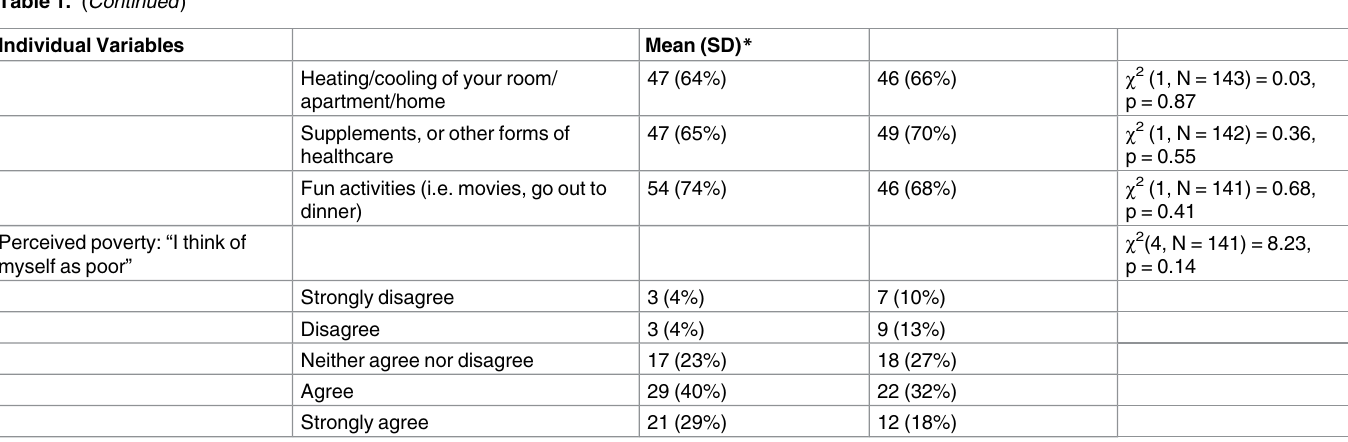
Table 2. Socio-demographic, Stigma, and Health Variables by Housing Insecurity Among Survey Participants in the African and Caribbean Black Women’s Stigma and Health Study: Ontario, Canada, 2011. Variable